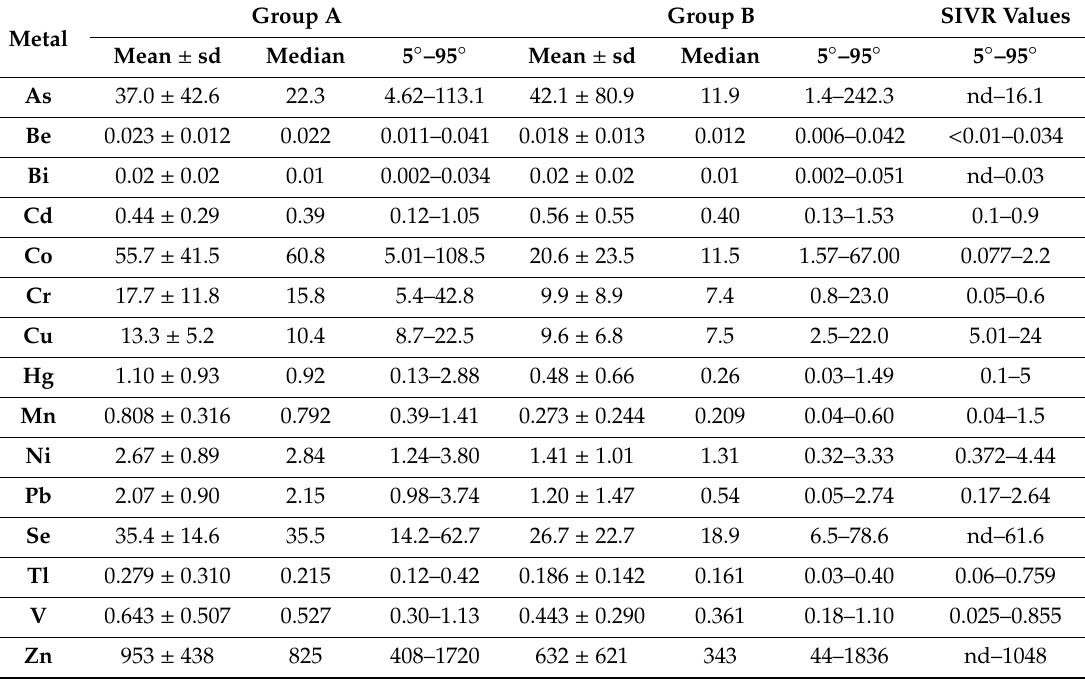
Table 2. Concentration of metal ions in the urine of two groups of patients and reference values ( µ g / L) established by the Italian Society of Reference Values